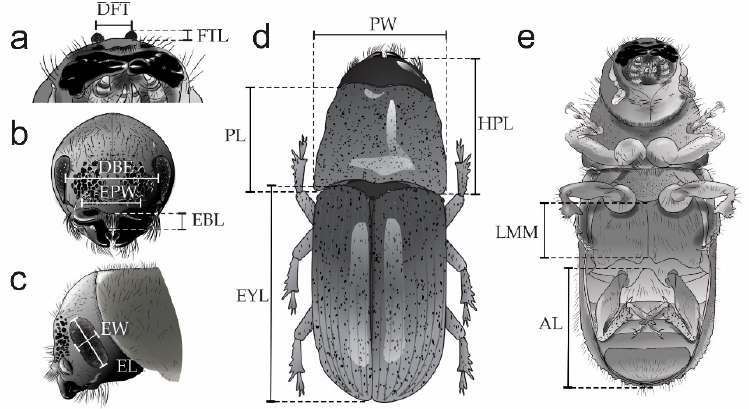
Figure 3. Quantitative characters evaluated in D . brevicomis populations: FTL —Frontal tubercles length, DFT —Distance between frontal tubercles, EBL —Epistomal brush length, EPW —Epistomal process width, EW —Eye width, EL —Eye length, DBE —Distance between eyes, HPL —Head-pronotum length, PL —Pronotum length, PW —Pronotum width, LMM —Length of the midline of the pronotum